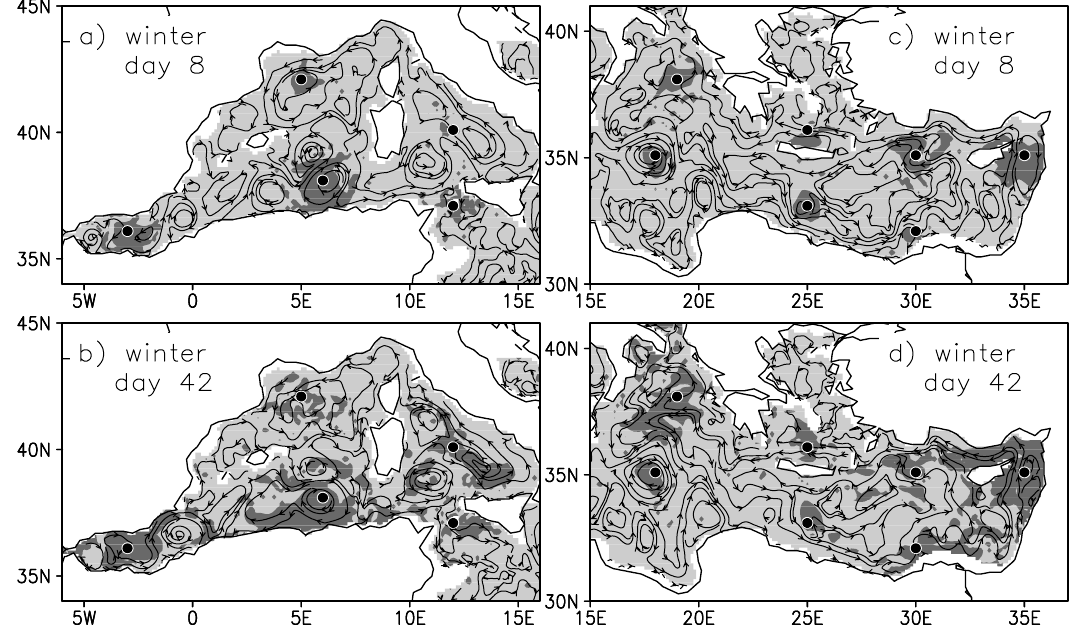
Fig. 12. Maps of data impact and basin circulation (streamlines) in the winter experiment at 50m depth: western basin, day 8 (a) and day 42 (b) ; eastern basin, day 8 (c) and day 42 (d) . The circulation shown is the average during the days 1–8 and 35–42, respectively. Dark grey indicates impact greater than 0.3. Black dots indicate the data